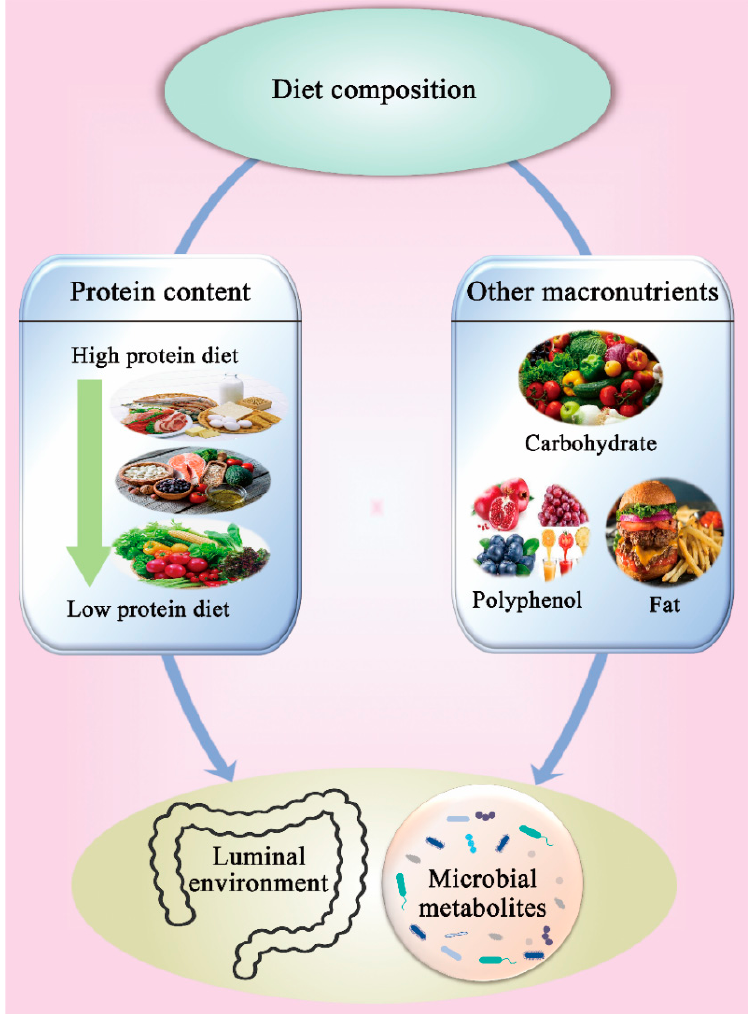
Figure 3. The effect of diet composition on gut microbiota.